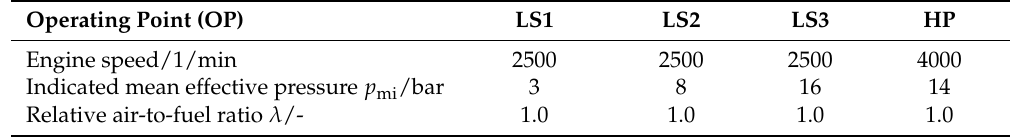
Table 2. Simulated operating points (OPs). LS, load sweep; HP, high power.